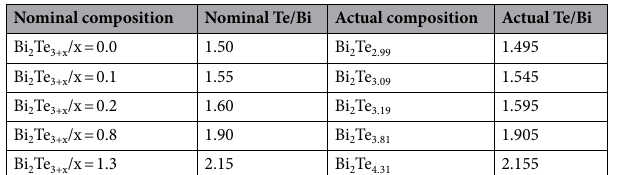
Nominal composition Nominal Te/Bi Actual composition Actual